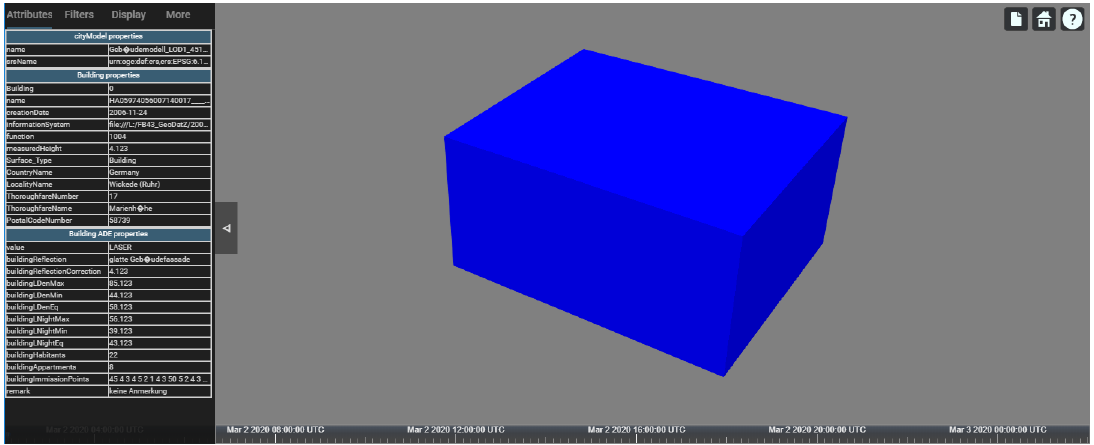
Figure 4. Result of the process described in Section